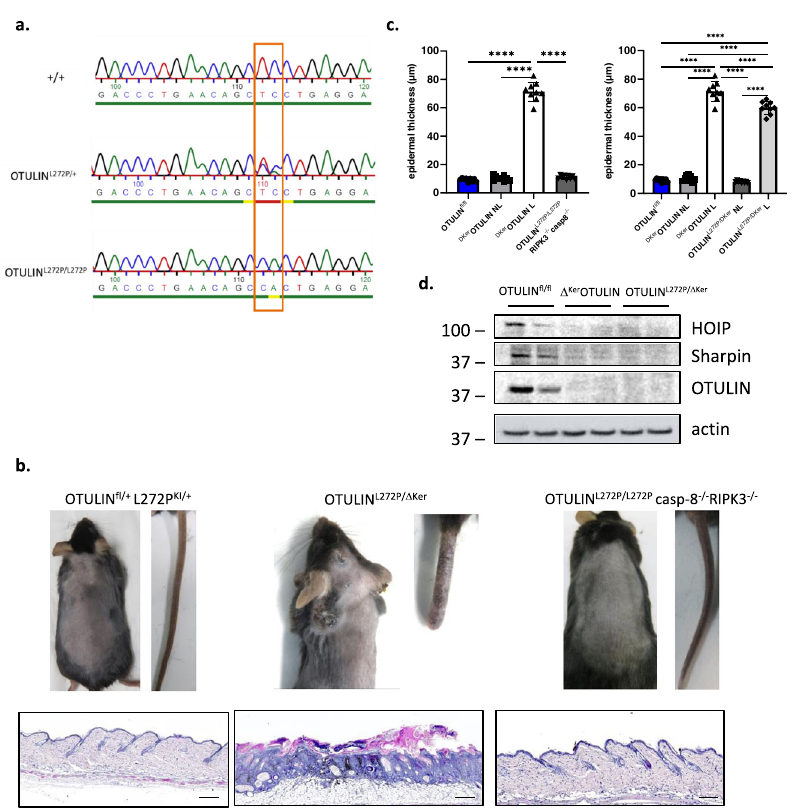
Fig. 7 Knockin of a human mutation in the murine Otulin gene phenocopies OTULIN-de fi ciency. a Targetting strategy for introduction of L272P mutation in the murine Otulin allele. b Representative images of the back skin and tail (upper panel), and H&E-stained skin sections (lower panel) of OTULIN L272P/ + , OTULIN L272P/ Δ Ker , and OTULIN L272P/L272P casp8 − / − RIPK3 − / − mice. Scale bars: 200 μ m. c Epidermal thickness quanti fi cation of skin of 7 − 11 weeks old mice. NL non-lesional; L lesional ( n = 10 per condition; **** p < 0.0001, One-way ANOVA with multiple comparisons). Data represent means ± SEM. d Immunoblotting on epidermal tail lysates of 7-week old OTULIN fl / fl ( n = 2), Δ Ker OTULIN ( n = 2) and OTULIN L272P/ Δ Ker ( n = 2) mice using antibodies detecting HOIP, SHARPIN, and OTULIN. Anti-actin is shown as loading control. Molecular weight marker units are in kilodalton (kD). Methods GAACAGCTCCTG 3 ′ and 150 ng/µl single-stranded DNA repair template with Mice . The following mouse lines were used: Otulin FL 24 , K14-Cre 25 , Fadd FL 45 , sequence 5 ′ - AAGTGCCGTTCTTCTCTGTGCTCTTGTTTGCCCGAGACACA TCCAATGACCCTGAACAGCCACTGAGGAACCACCTAAACCAGGTGGGAC Mlkl FL 46 , Ripk1 D138N 47 , Tnfr1 − / − 48 , Ifnar1 − / − 49 , IL1r − / − 50 , Myd88 − / − 51 , ACACGGGGGGCCTTGAGCAGGTGAGTTGTGGC-3 ′ (iDT) containing the casp8 − / − 52 , and Ripk3 − / − 53 . All alleles were maintained on a C57BL/6 genetic L272P mutation (CTC >CCA). The embryos were transferred to foster mothers the background. Mice were housed in individually-ventilated cages at the VIB Centre same day through oviduct transfer. Effective mutagenesis was con fi rmed by for In fl ammation Research, in a speci fi c pathogen-free animal facility at 20 − 24 °C sequencing of the Otulin gene on genomic DNA. and 45 − 65% humidity with a 12h light/dark cycle and food and water available at libitum. All experiments on mice were conducted according to institutional, national, and European animal regulations for animal testing and research. Animal protocols were approved by the VIB-Ghent University ethical review board. injection daily from the age of 18 days on and for a period of 30 days, or with Generation of OTULIN L272P knockin mice . For the generation of OTULIN L272P 40 mg/kg anti-MCP-1 antibody (InVivoMab, BE0185) IP twice a week from the age knockin mice, C57BL/6J zygotes were electroporated with 40 ng/µl Cas9 protein of 18 days on and for a period of 30 days. (iDT), 8ng/µl cr/tracrRNA duplex (iDT) with guide sequence 5 ′ ATGACCCT NATURE COMMUNICATIONS| (2021) 12:5913